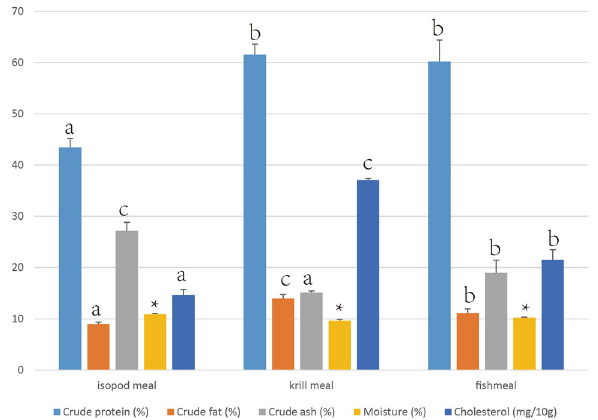
Figure 4. General nutritional components of isopod meal, antarctic krill meal and fishmeal (wet weight ± 95% confidence interval). Numerical values marked in the top of column with the same letter a, b or c or * are not statistically significantly different.